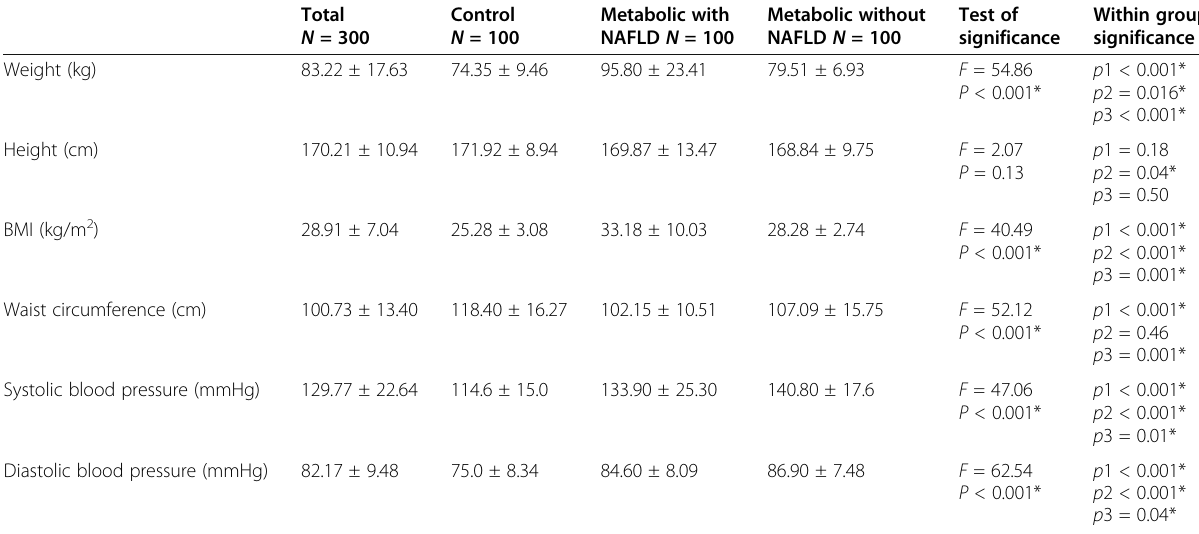
Table 2 Clinical characteristics among the studied